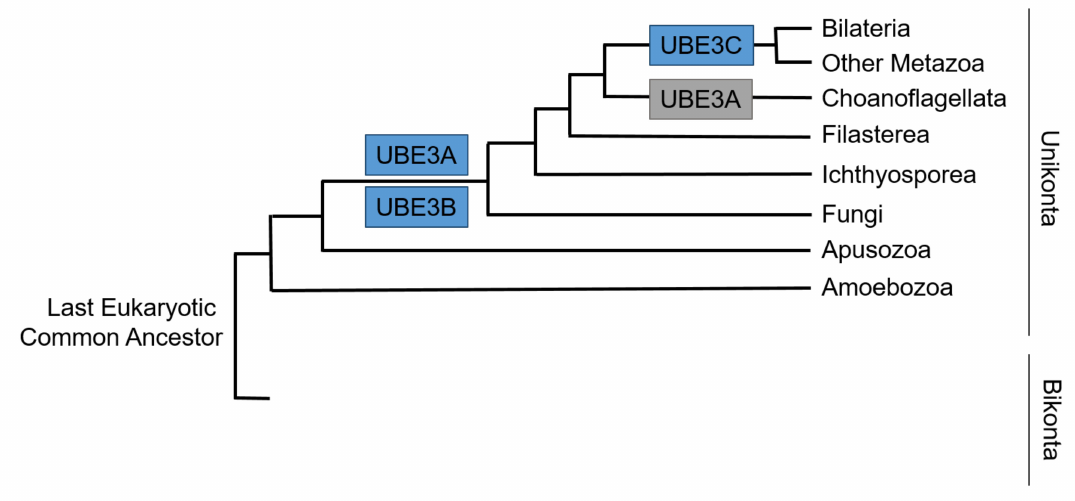
Figure 3. Simplified pattern of acquisition of Ubiquitin Ligases E3s (UBE3s) across the tree of life of Eucaryota based on [44]. Gains are colored in blue and losses in